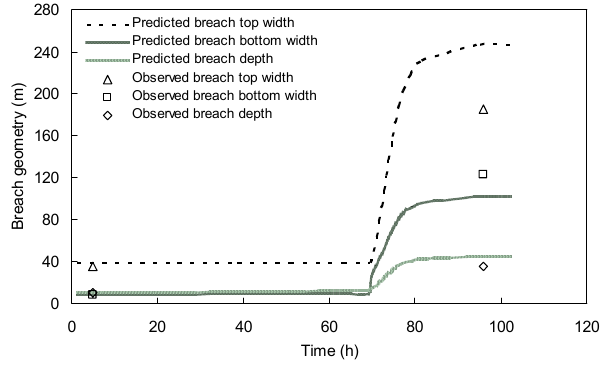
Fig. 9. Predicted and observed outflow hydrographs for Tangjiashan Landslide Dam (observed data from Liu et al., 2009b).